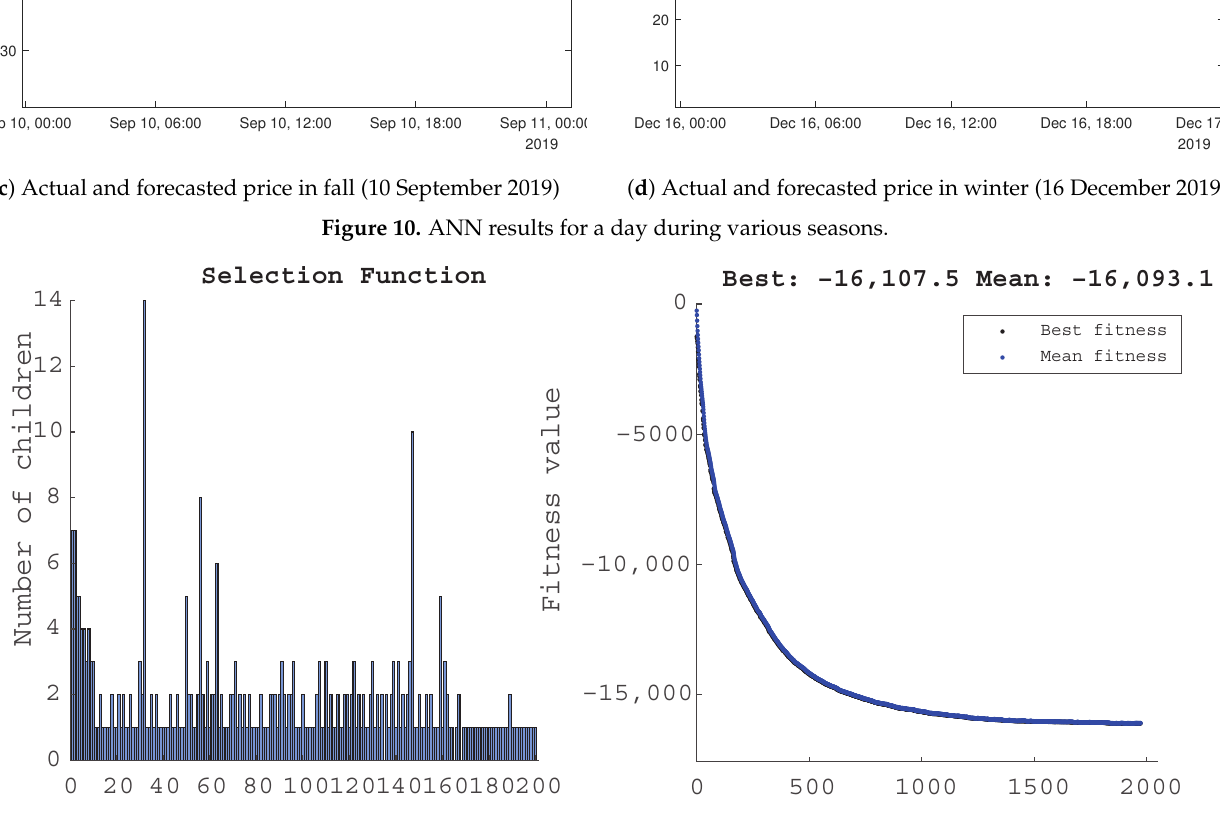
Figure 11. Selection and fitness functions from GA for Spring (26 April